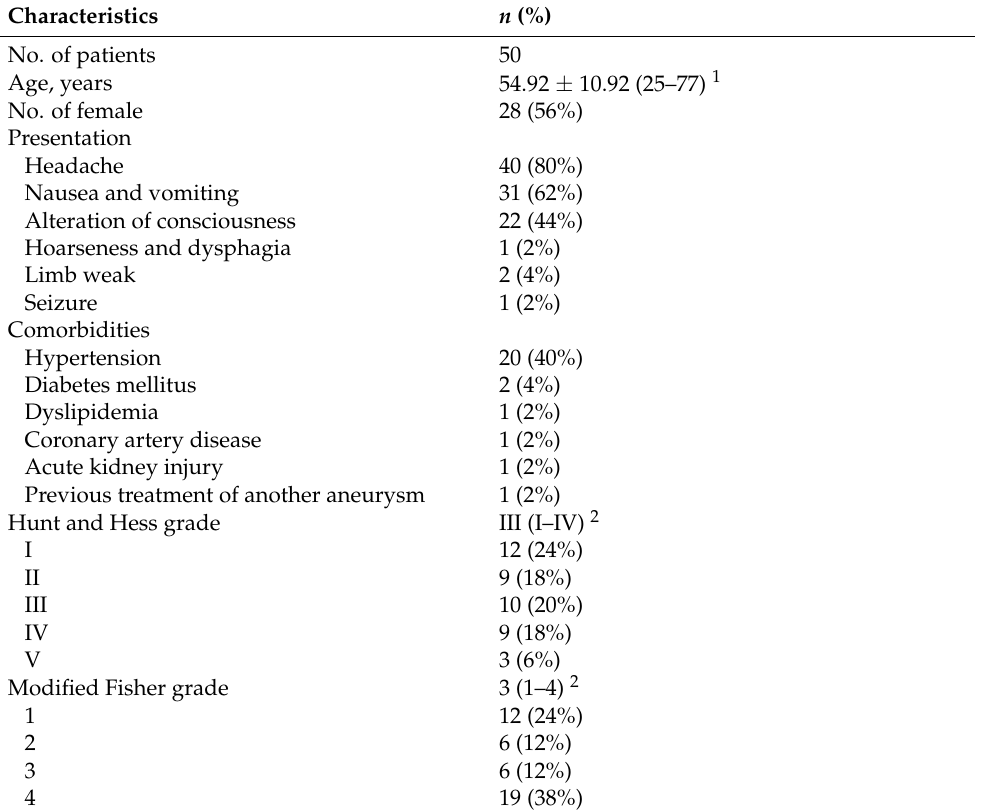
Table 1. Demographic and clinical characteristics.